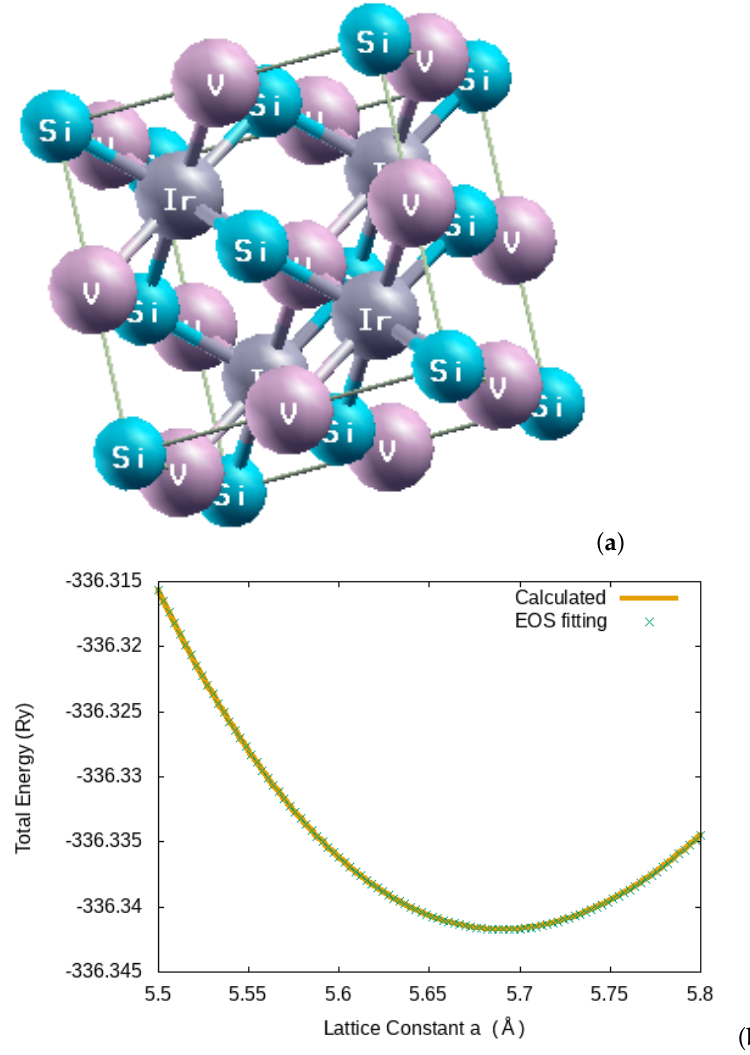
Figure 1. ( a ) The crystal structure and ( b ) optimization of the lattice parameters of VIrSi half- Heusler